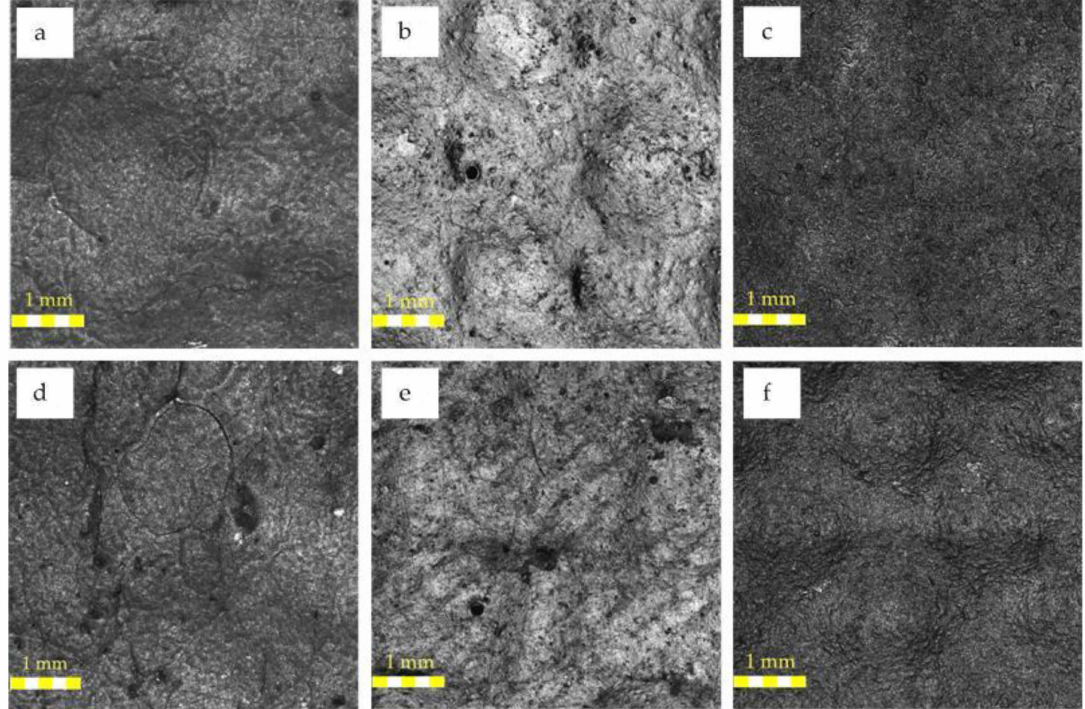
Figure 8. Microstructures of tested samples: reference sample: ( a ) grey, ( b ) red, and ( c ) white. Microstructures of the sample after natural conditions: ( d ) grey, ( e ) red, and ( f ) white.